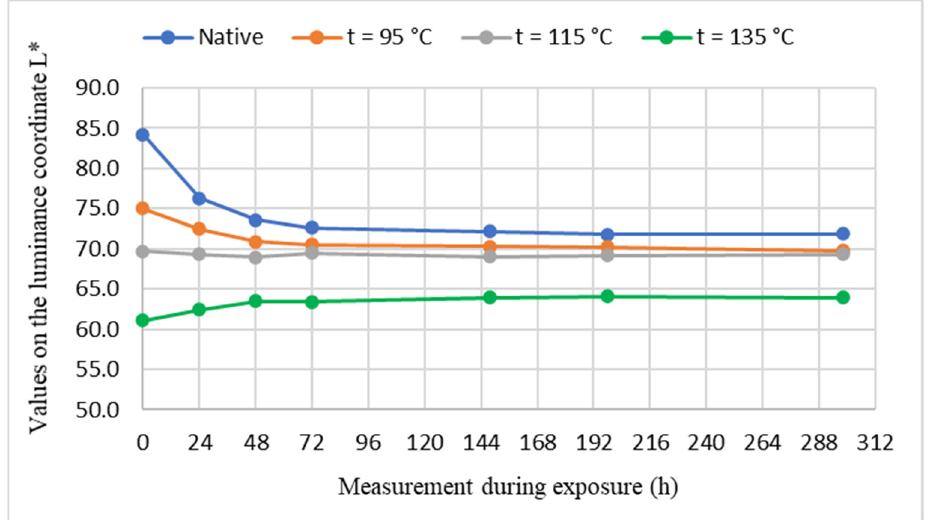
Figure 2. The course of changes of values on the light coordinate L* in the process of UV irradiation of samples of unsteamed and steamed maple wood.